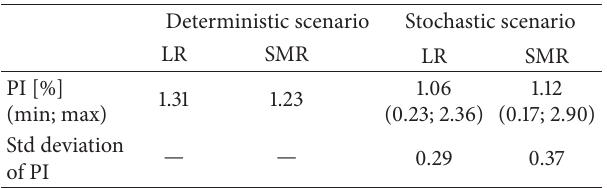
Table 3: Profitability Index (PI) for multiple SMR and stand-alone LR in deterministic/stochastic scenarios [19].